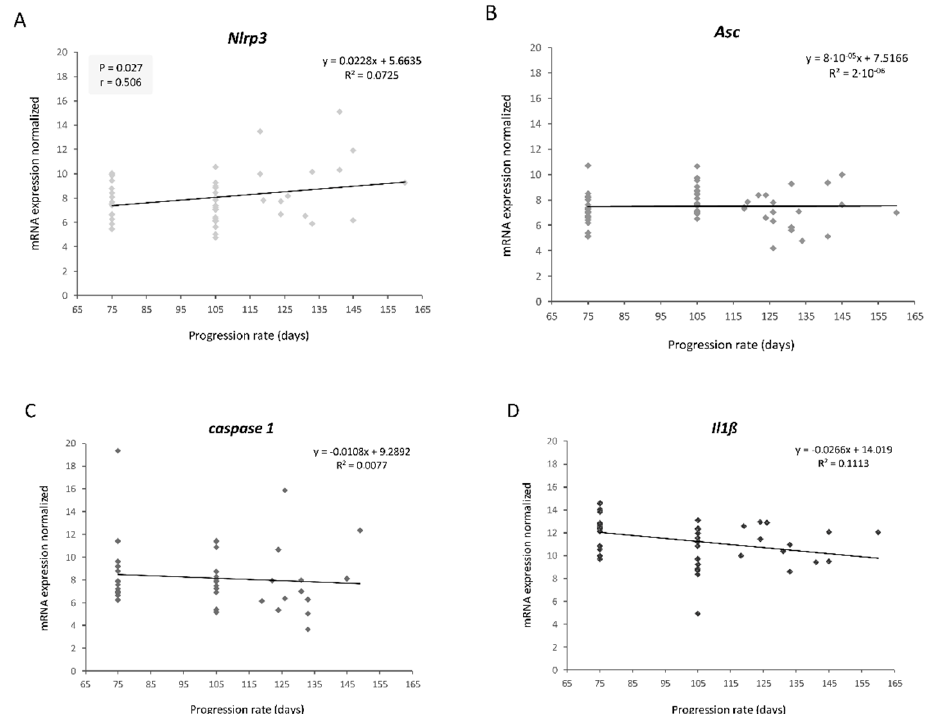
Figure 2. Linear correlation graphs between longevity and transcriptional expression levels of NLRP3 inflammasome components throughout disease progression: ( A ) Nlrp3 , ( B ) Asc , ( C ) caspase 1 , ( D ) Il1 β . Only Nlrp3 levels showed a significant and positive correlation with longevity. The total number of transgenic SOD1G93A mice used was 20. Three skeletal muscle biopsies were obtained per mouse, at different stages: early symptomatic stage (75 days), symptomatic stage (105 days) and terminal stage (endpoint